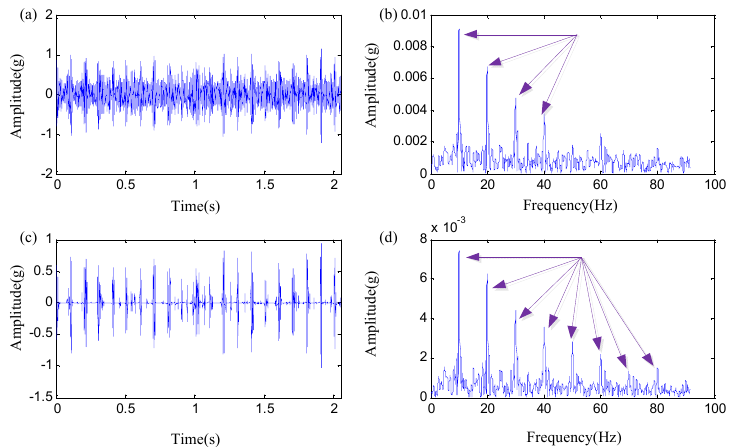
Figure 3. ( a ) Extracted feature signal by optimal VMD. ( b ) Envelope spectrum of extracted feature signal. ( c ) De-noising signal. ( d ) Envelope spectrum of the de-noising signal.